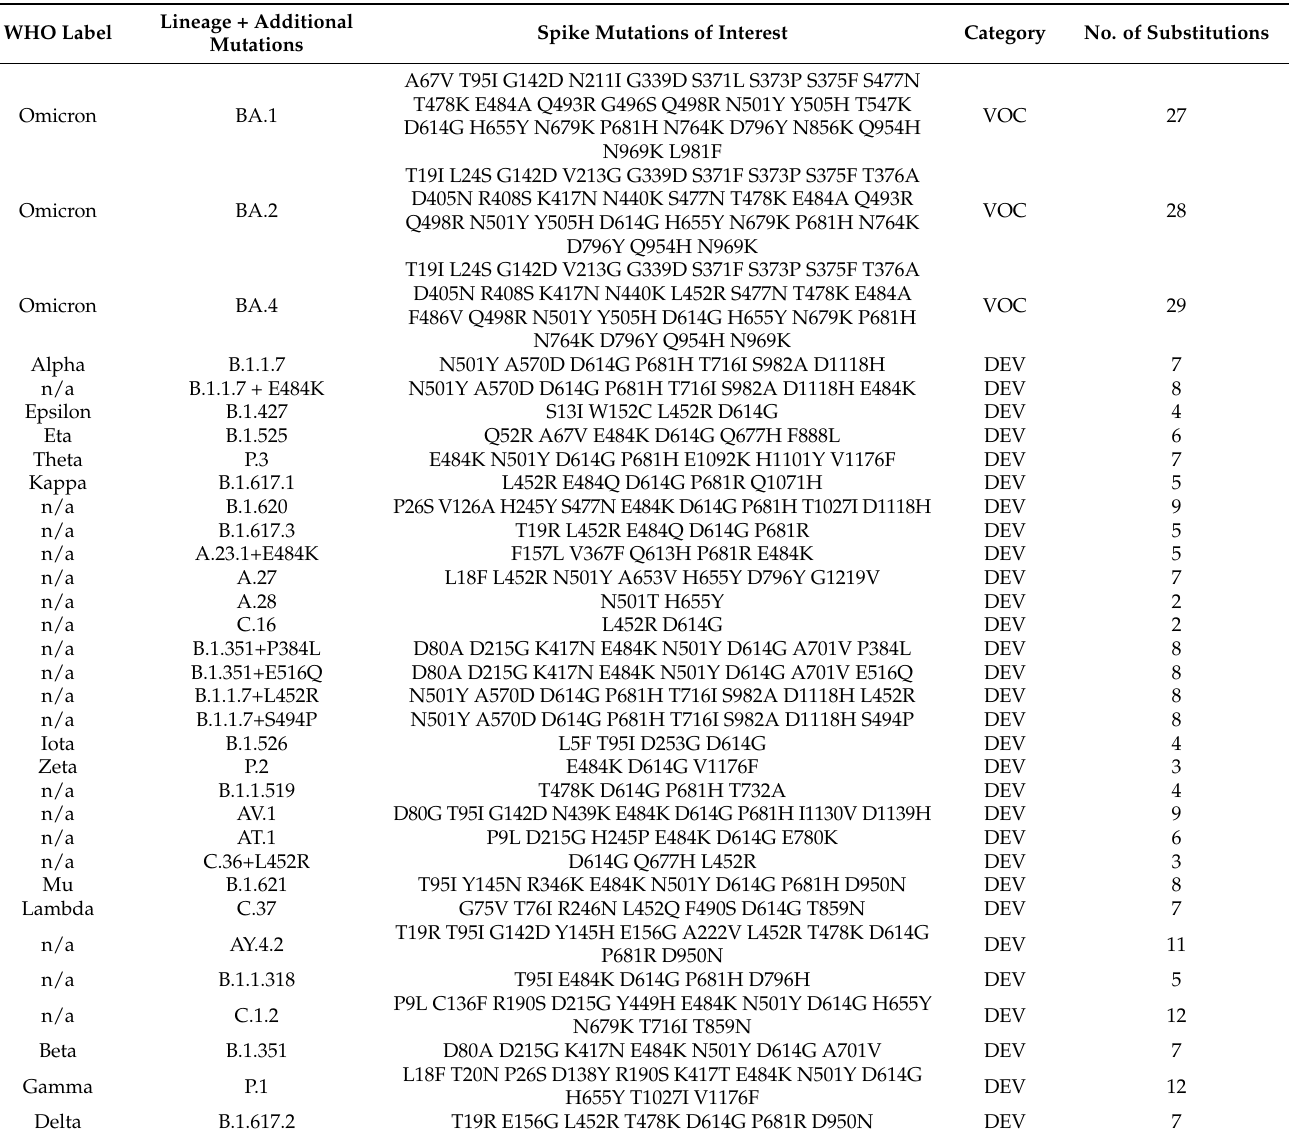
Table 2. Summary of the 33 variants of the spike